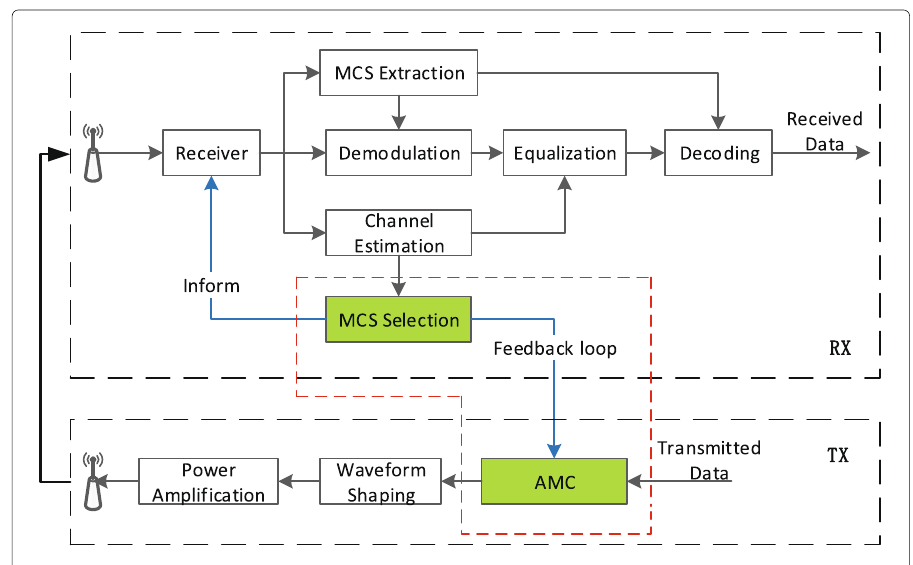
Fig. 1 The system model of AMC in